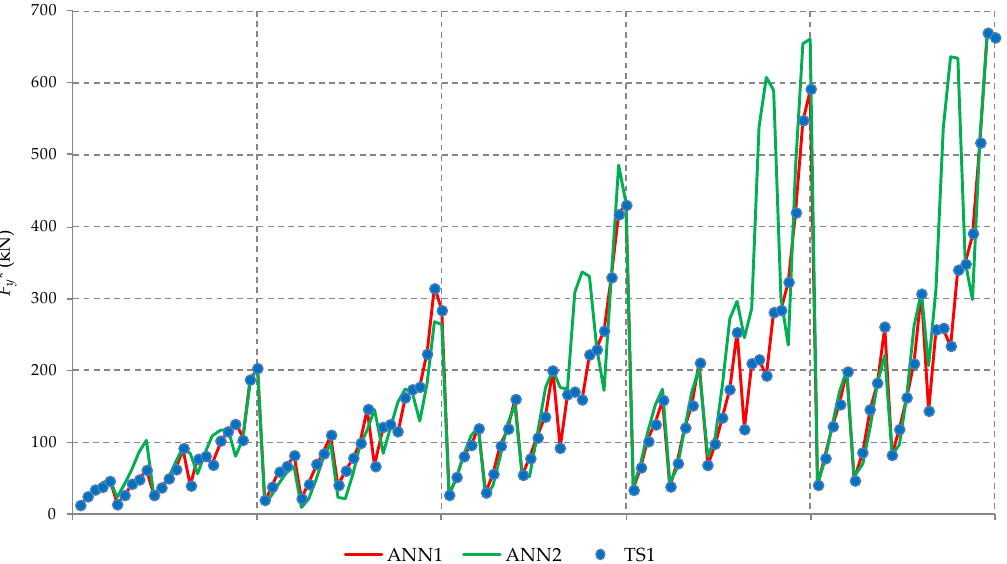
Figure 8. Results comparison for the F y* values.